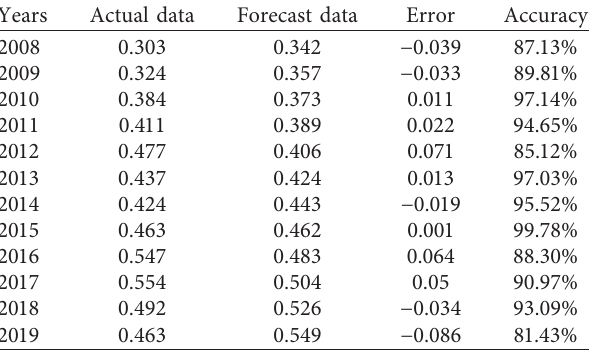
Table 2: The prediction and fitting data of the power function regression model.